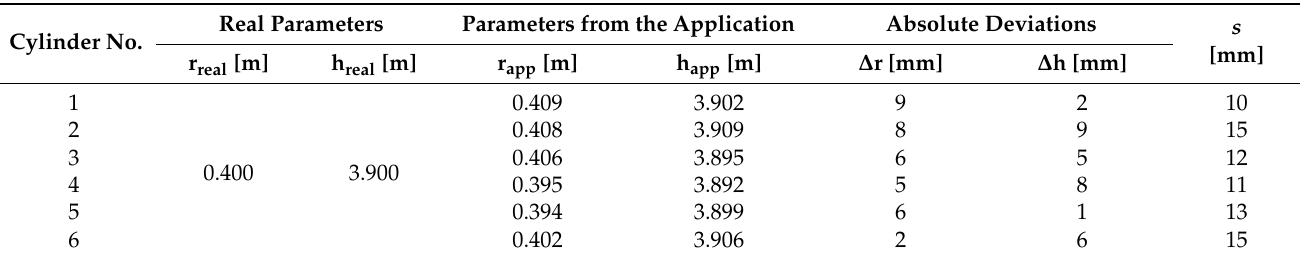
Table 1. Real parameters and parameters from the application with the calculated absolute deviations for the cylinders.